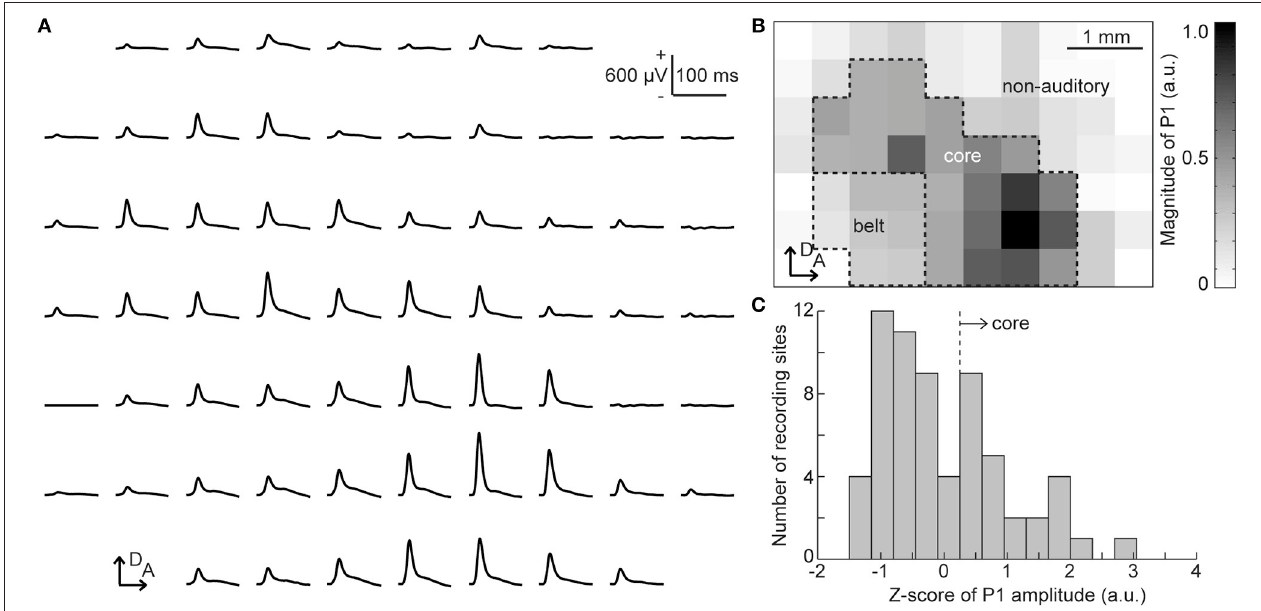
FIGURE 2 | Identification of the putative auditory area. (A) Representative mapping of grand-averaged auditory evoked potential (AEP) waveforms for 60 clicks. Each AEP waveform is approximately aligned in the spatial coordinates of the 64 sites of the surface microelectrode array. At each recording site, the P1 amplitude was quantified as the maximum potential within 50ms from the stimulus onset. (B) Spatial distribution of the click-evoked P1. The gray level corresponds to the P1 amplitude measured at each electrode in the array. The putative core region and belt region were determined according to P1 amplitudes, and other sites comprised the non-auditory region. Both the core and belt regions were considered as the auditory area in this study. (C) Histogram of the z-scores of P1 amplitude. The core region was defined as the recording sites where z-scores had larger values than the automatically-calculated threshold (broken line). A, anterior; D,